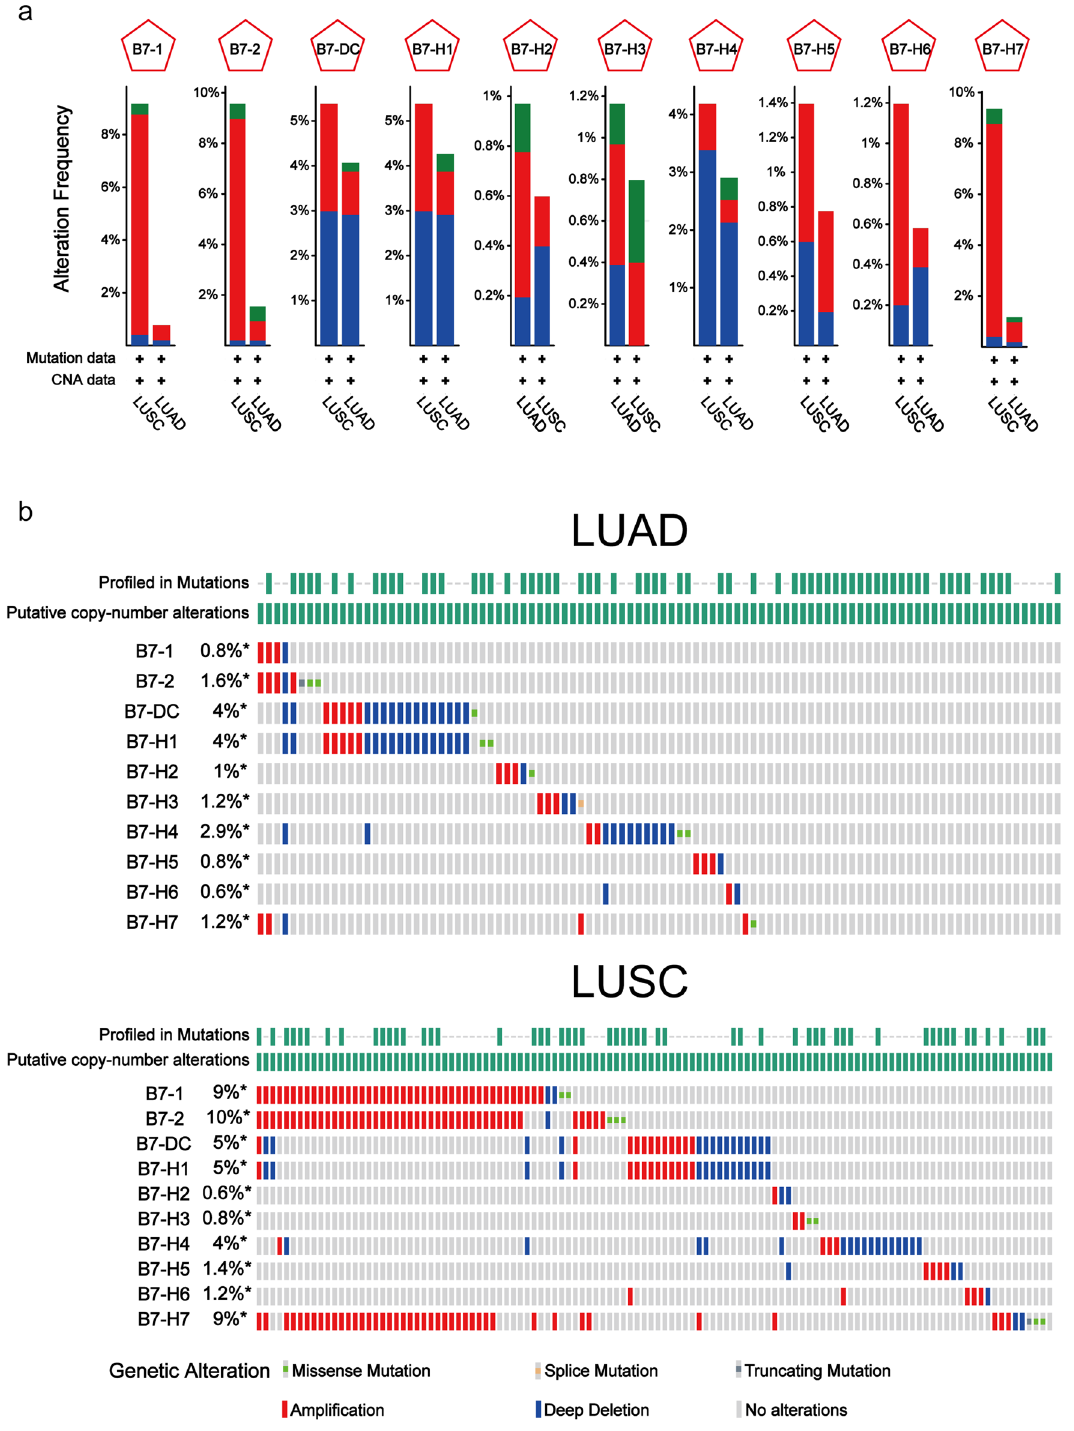
Figure 2. Genetic alterations of B7 family in different subtypes of NSCLC. ( a ) The frequency of genetic alterations in B7 family members in NSCLC. The types of changes include mutations (green), amplifications (red), and deep deletions (blue). ( b ) The gene mutation rate of B7 family members was analyzed, including missense mutations (green), truncation mutations (dark gray), amplification (red), deep deletion (blue) and no change